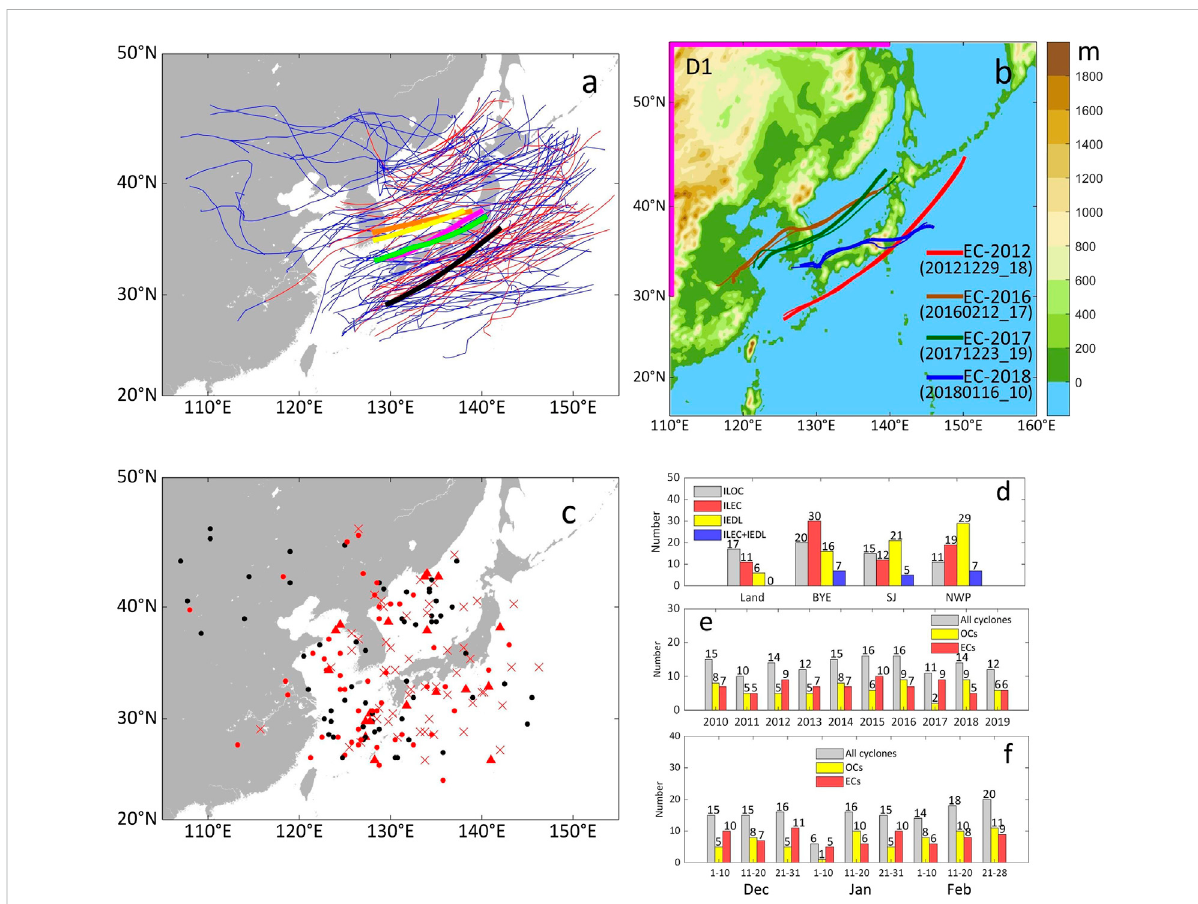
FIGURE 3 Distribution of cyclones over East Asia in 10 winters. Thin lines in (A) show the tracks for 135 cyclones, with red parts denoting where cyclones wereexplosively deepened. Thickorange, yellow, purple, green, and black linesdenote the average 24-h tracks for OCs, weak, medium, strong, and super ECs, respectively. Black and red dots in (C) show the initial locations for OCs and ECs (denoted by ILOC and ILEC). Red crosses show the initial explosive deepening locations for ECs (denoted by IEDL), and red triangles show the initial locations for ECs which went through explosive deepeningfromthebeginning(denotedbyILEC+IEDL).Barsin (D) denotethenumbersofthefourkindsoflocationsoverland,Region-BYE,Region- SJ,and Region-NWP (located inFigure 1A).Barsin (E) and (F) denote thenumbers ofcyclones indifferentyearsand differentdates, respectively. The model domain for WRF modeling discussed in Section 4 is shown in (B) . Shadings denote the terrain. Thick purple lines locate the boundaries where thetemperatureismodi fi edforExp-MT.Otherthicklinesshowthetracksforthefour ECs,thinlinesshowtheirtrackssimulatedbyExp-Ctrl,andthe numbers show the initial moments of the four ECs in the form of yyyymmdd_hh in